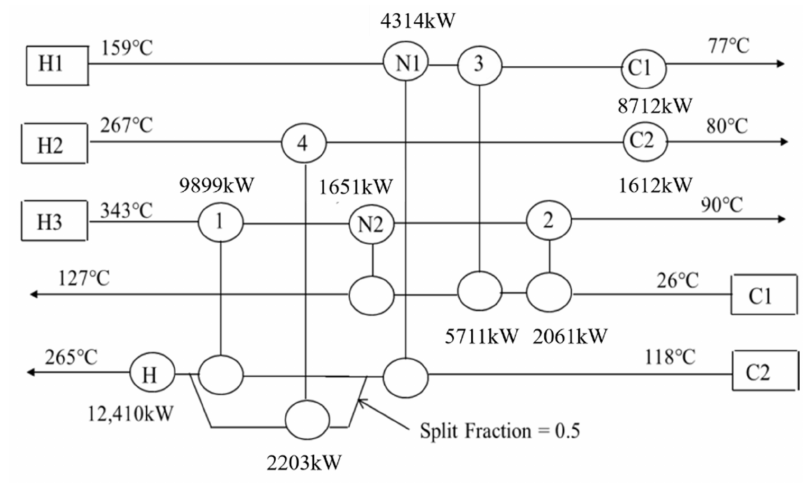
Figure 13. Best retrofit solution by applying S&T HE for case study 1.